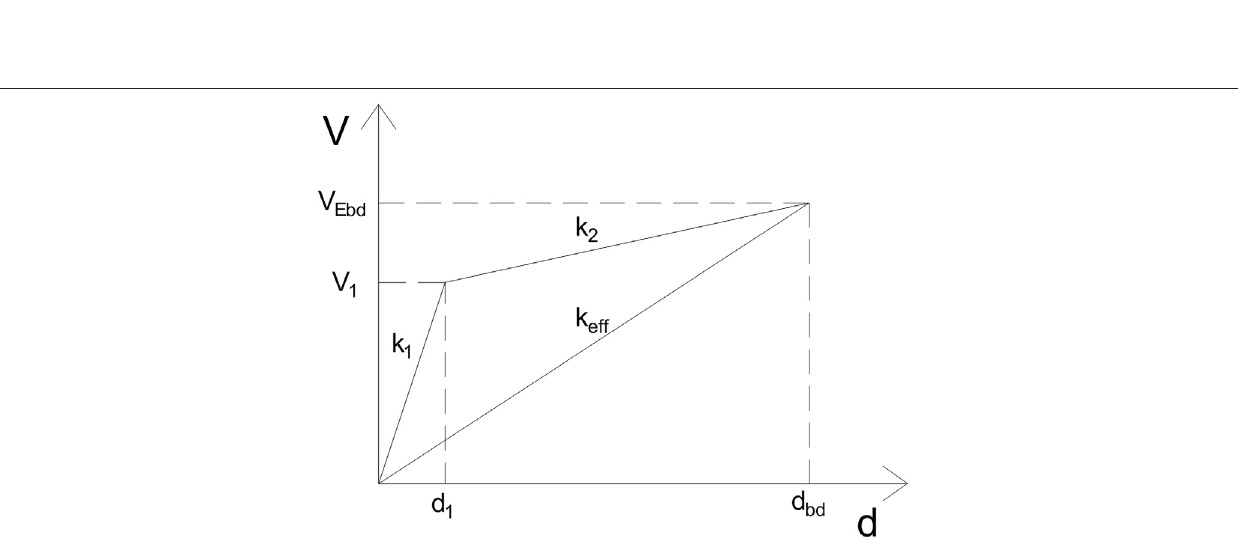
FIGURE 7 | Main parameters describing the hysteretic behavior of the